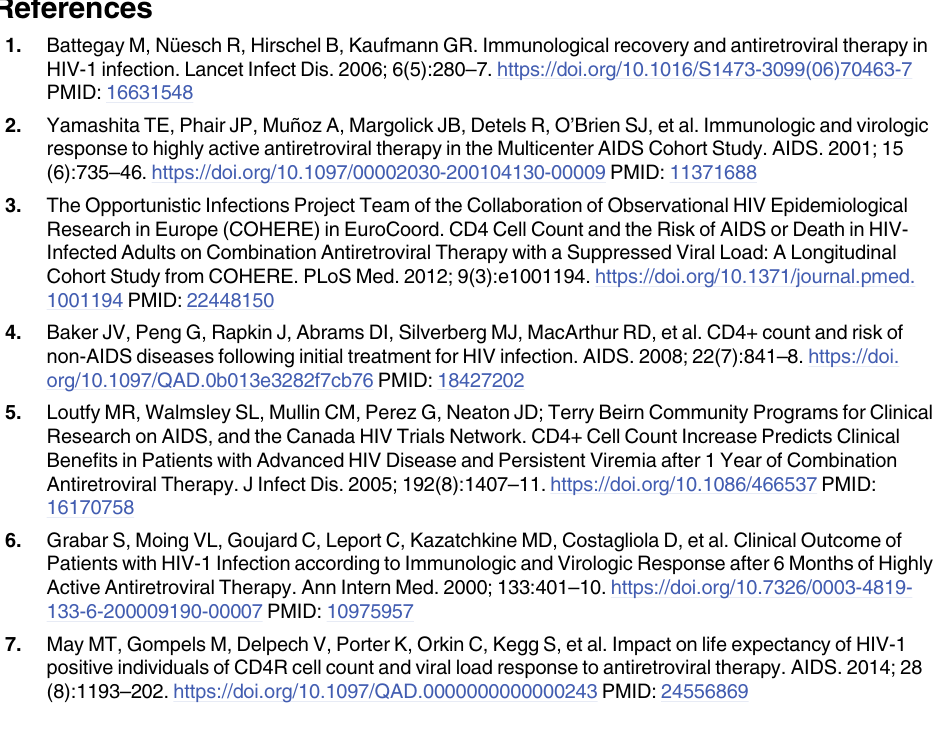
S1 Table. Baseline characteristics of patients included and excluded from the